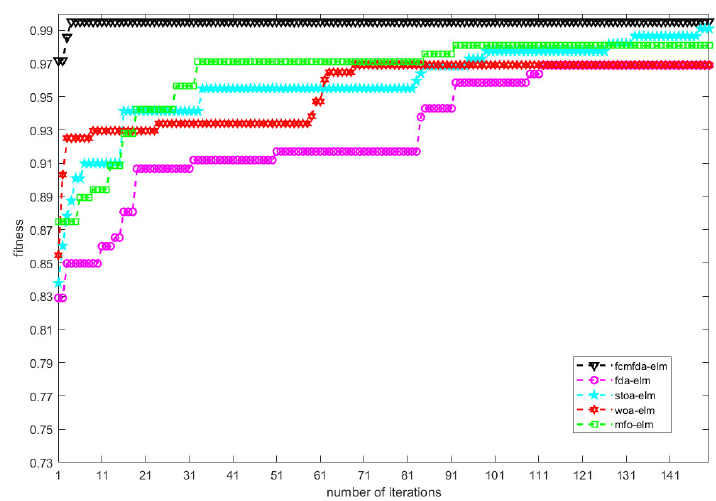
Figure 11. Convergence curve of each classification algorithm (Fish4Knowledge).